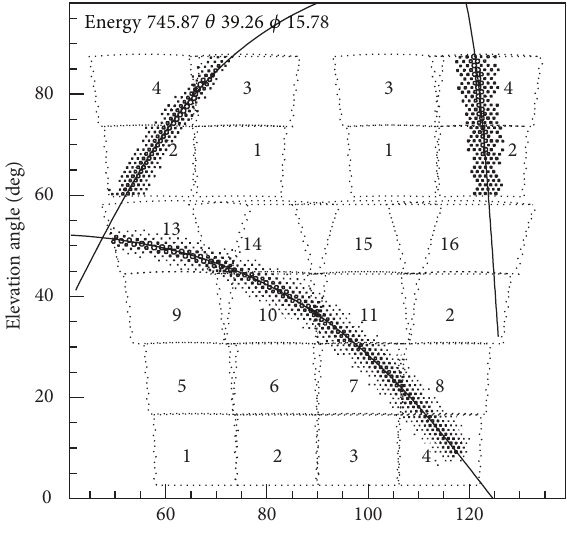
Figure 6: Detector aperture in different conditions. Solid circles are the aperture without any cut. Solid triangles are obtained using cut1 described in the text. Asterisks show the results obtained using